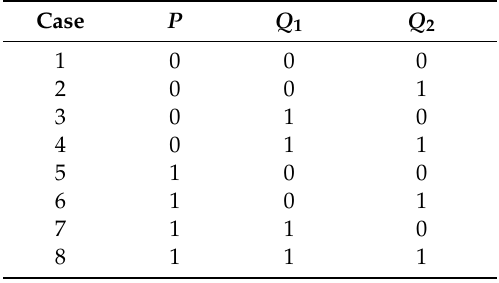
Table 1. PQ operating modes for the BTB-VSC 1